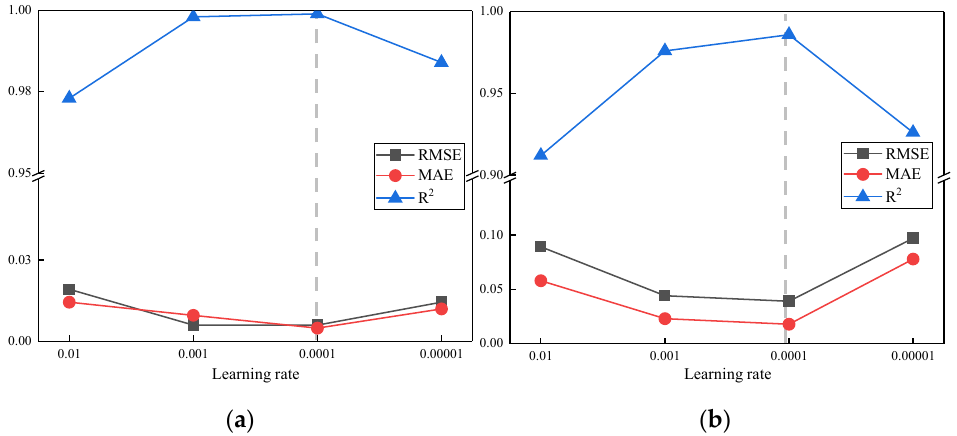
Figure 7. The trend of model prediction accuracy at different learning rates: ( a ) results of the training stage; ( b ) results of the testing stage.